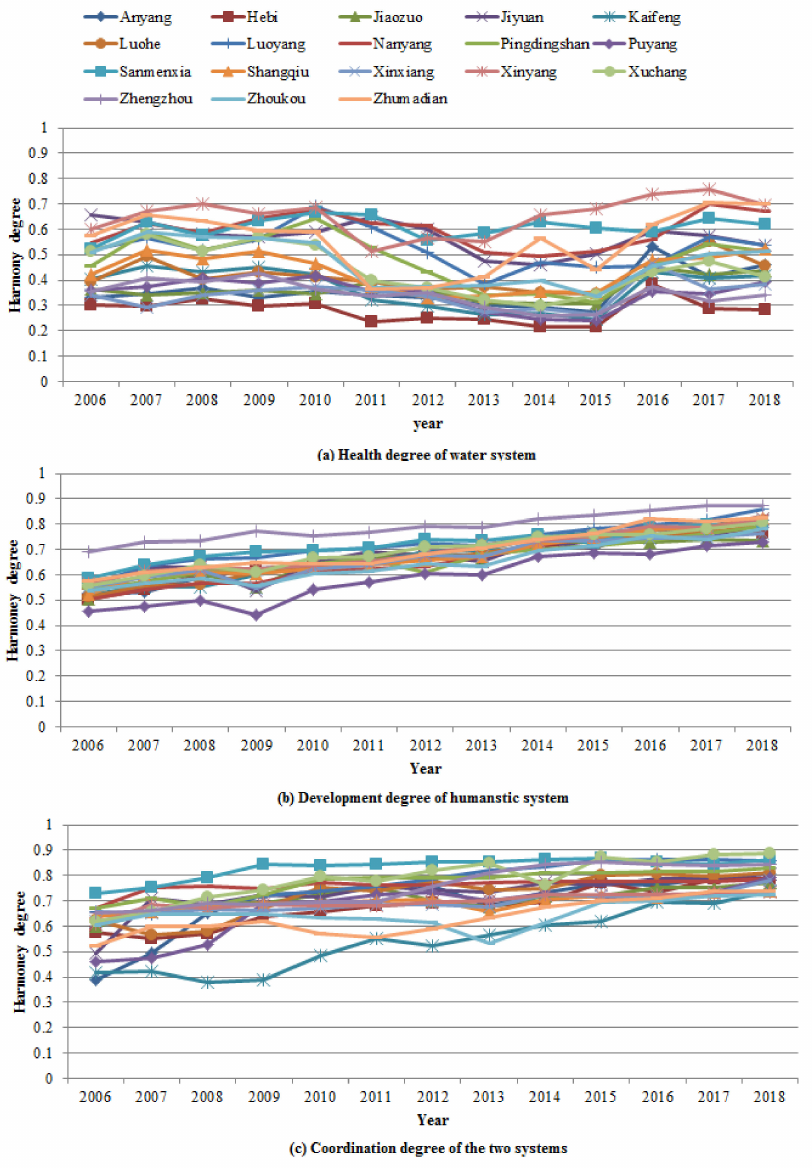
Figure 5. Evaluation results of the subsystem harmony degree for reflecting human–water relation- ship (HWR) in Henan Province from 2006 to